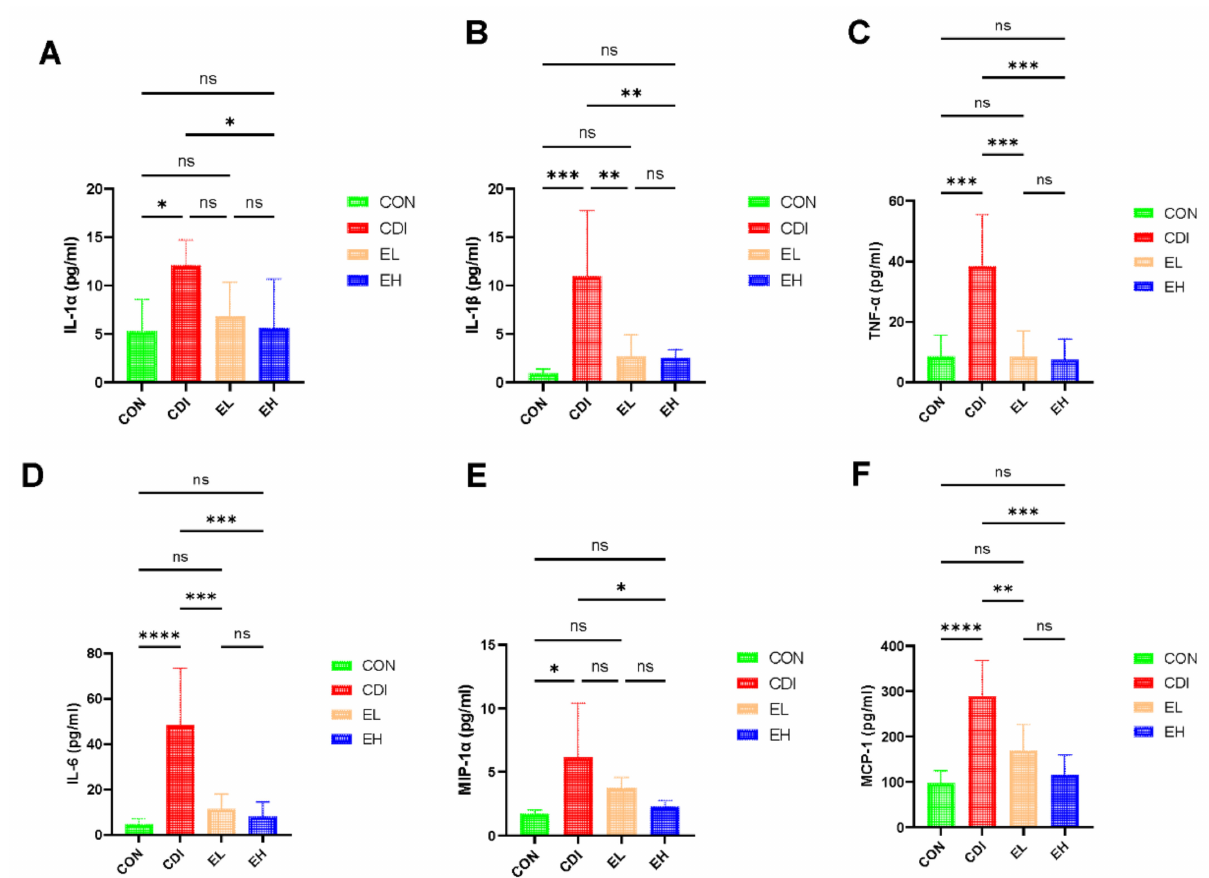
Figure 3. EGCG alleviates C. difficile -induced systemic inflammation. ( A ) IL-1 α , ( B ) IL-1 β , ( C ) TNF- α , ( D ) IL-6, ( E ) MIP-1 α , and ( F ) MCP-1. The bars indicate the serum levels of the cytokines and chemokines in mice. *, p < 0.05; **, p < 0.01; ***, p < 0.001; ****, p < 0.0001; ns, p >